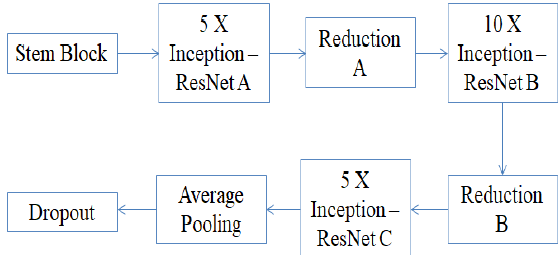
Figure 7. The architecture of Inception ResNet-v2.